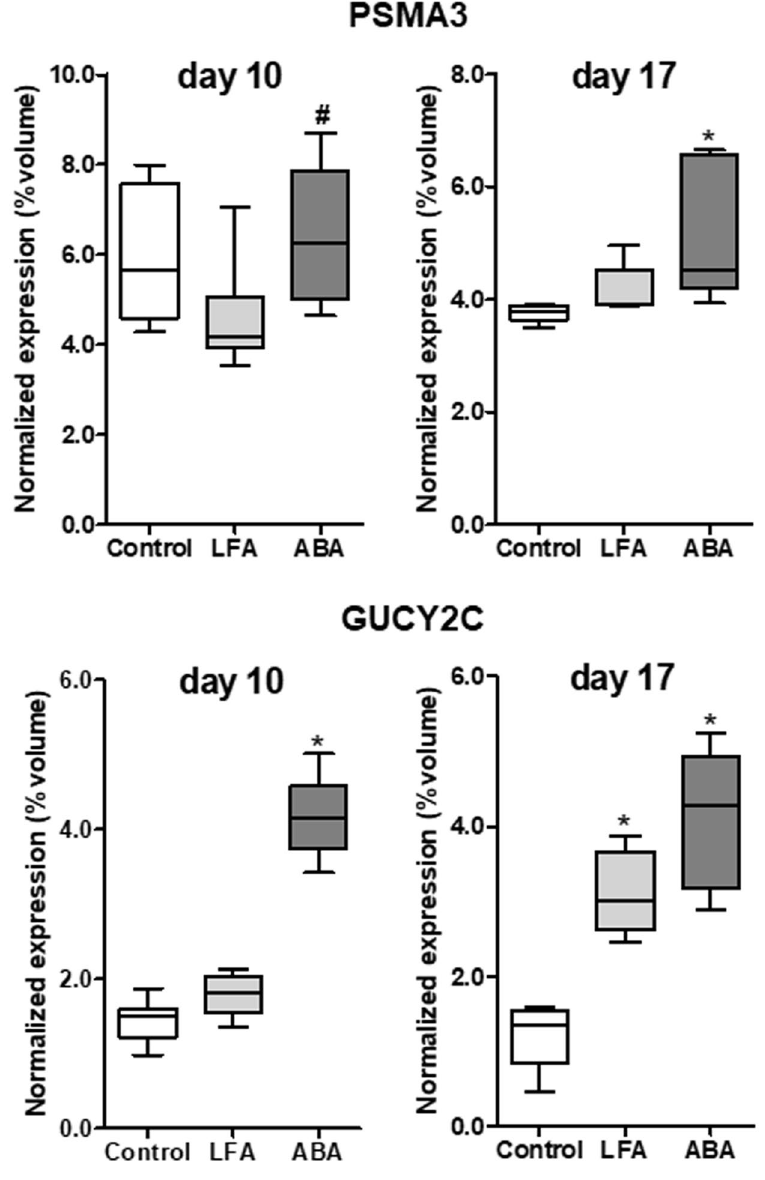
Figure 4. Hypothalamic proteins differentially expressed both at day 10 and day 17. Two differently modulated proteins were identified both at d10 and d17 (n = 6/group at each time). * p < 0.05 vs Control. # p < 0.05 vs LFA. PSMA3: Proteasome subunit alpha type 3; GUCY2C: Heat stable enterotoxin